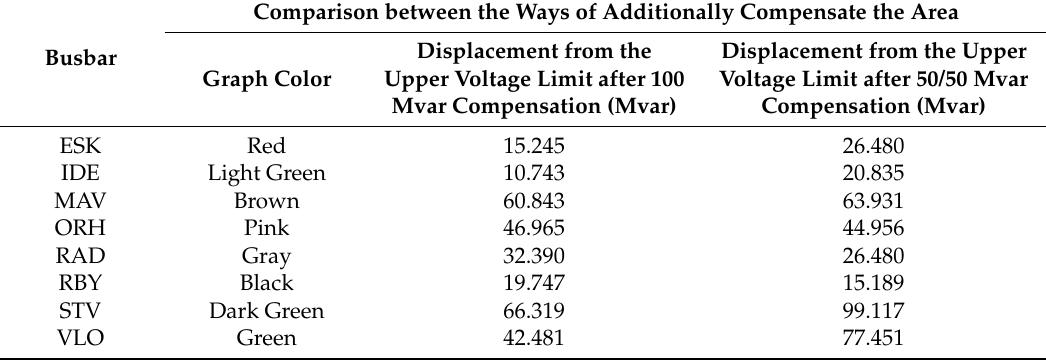
Table 5. The comparison between the two cases of reactive power